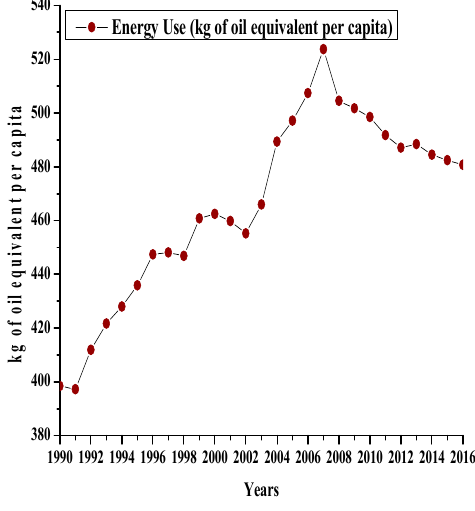
Figure 3. Electricity Access to the Urban Population.